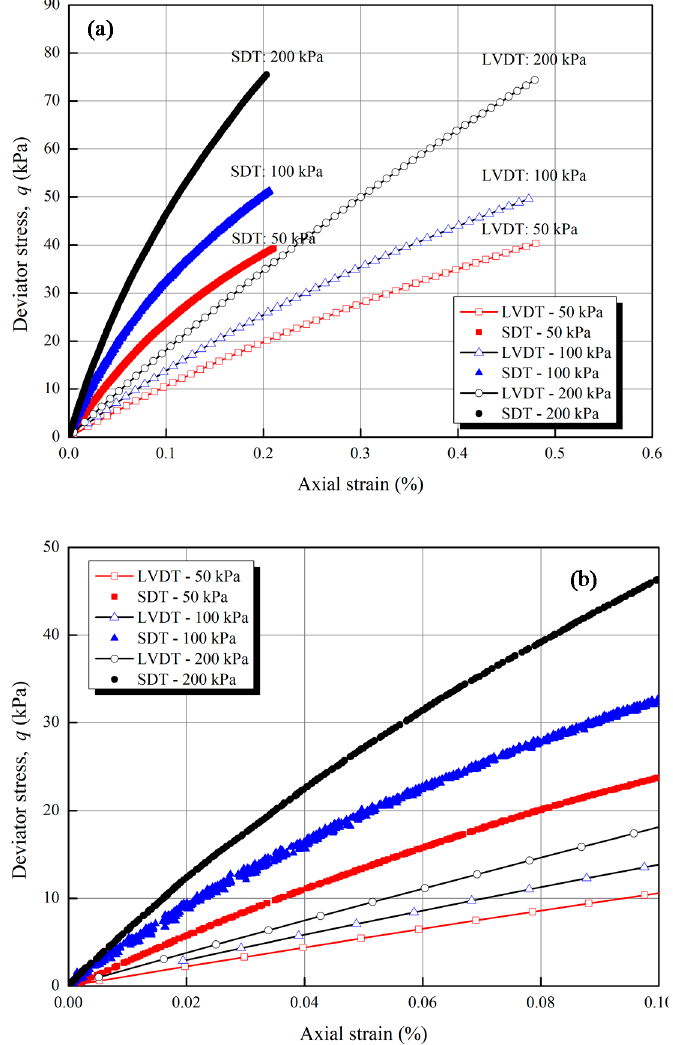
Figure 10. Stress-strain relationship between deviator stress and axial strain under different confining pressures: ( a ) Strain scale of 0 to 1%; ( b ) Strain scale of 0 to 0.1%.